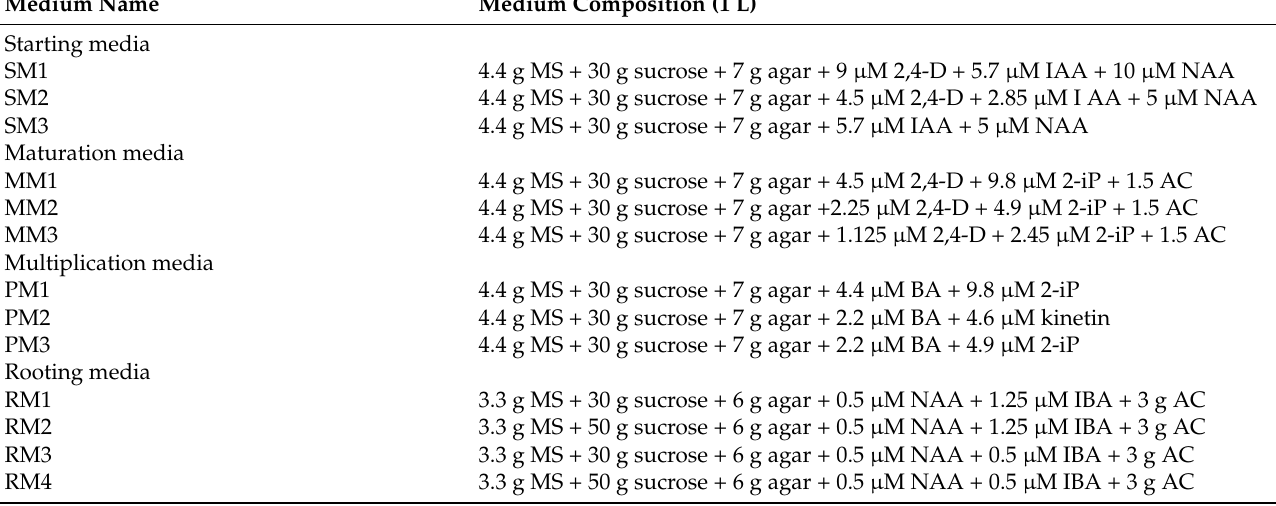
Table 4. Nutrient MS media composition used in several stages of micropropagation in date palm using immature female